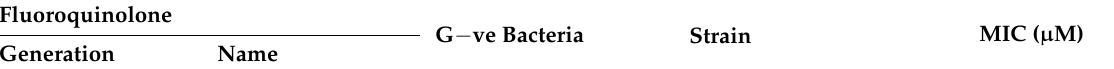
Table 4. Fluoroquinolones’ antibacterial activity against Gram-negative bacterial